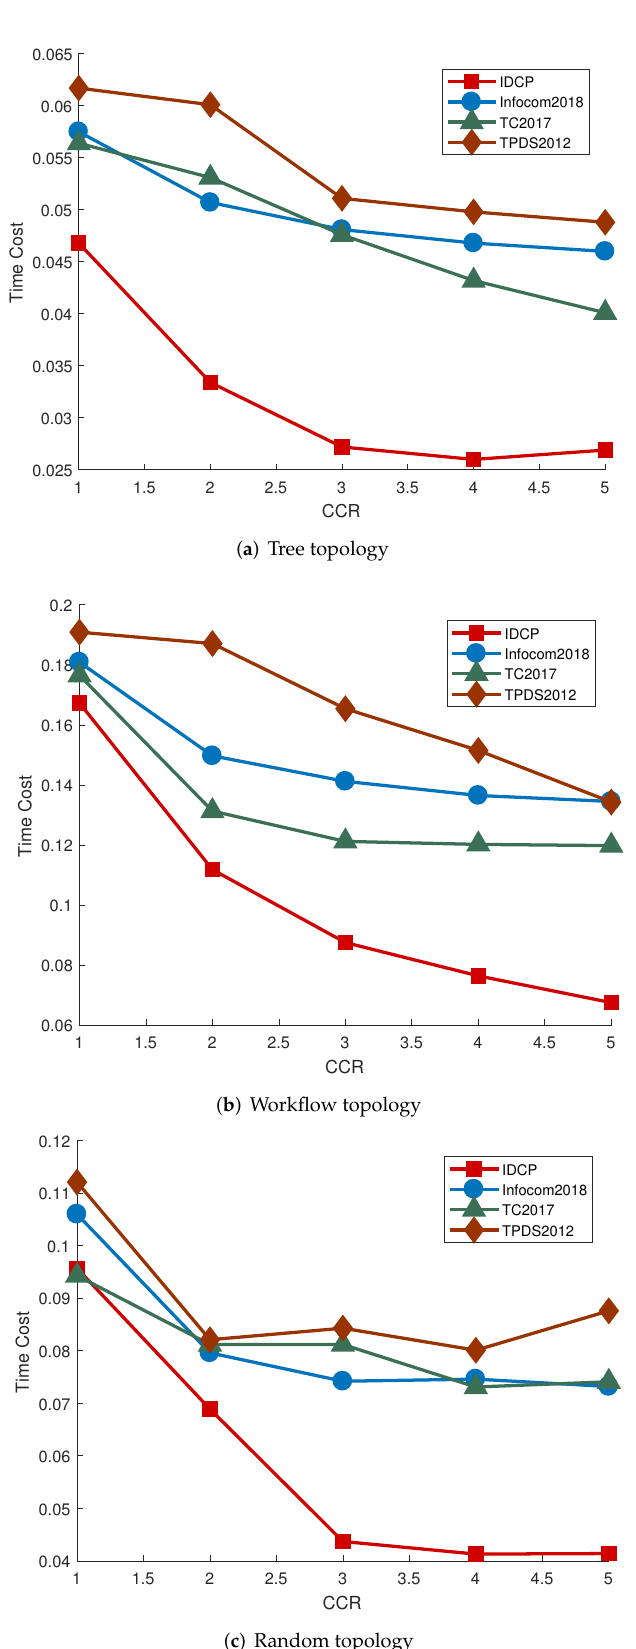
Figure 7. Time cost of different topologies under communication Computation Ratio